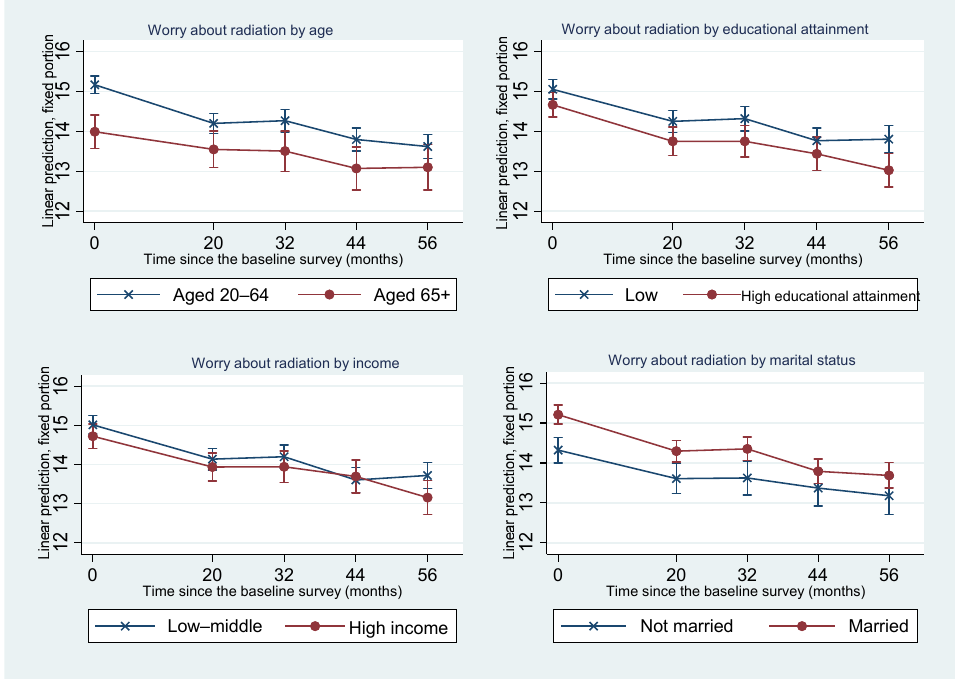
Figure 2. Changes in the adjusted predicted means of worry about radiation and 95% confidence intervals of those with and without each risk factor.